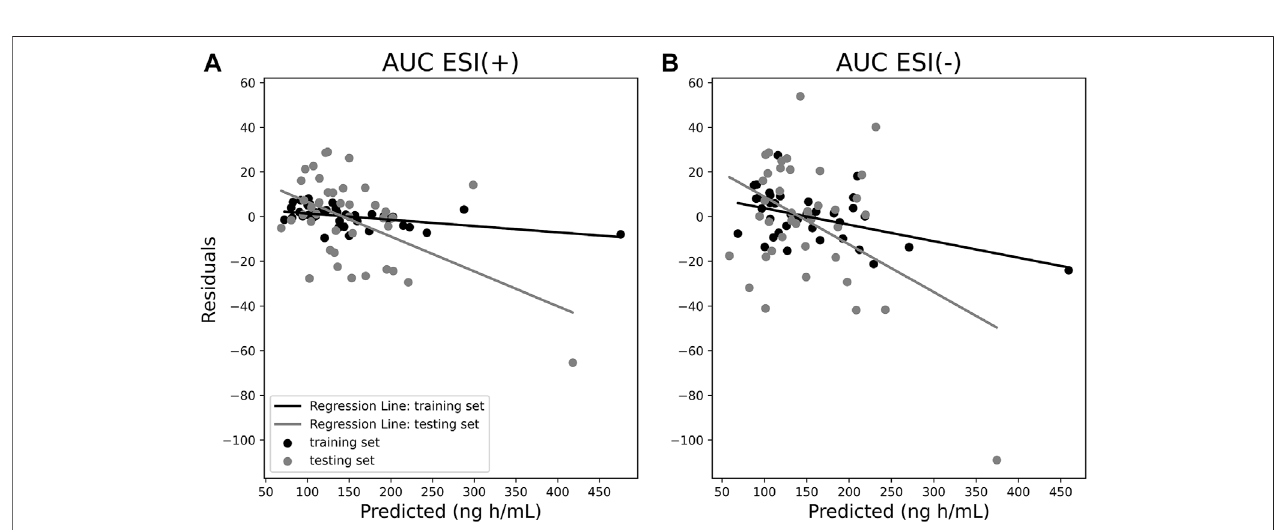
FIGURE 4 | Residual plots of ESI (+) (A) and ESI ( − ) (B) area under curve (AUC) models for both training (black dots) and leave-one-out cross-validation (LOOCv) testing samples (gray dots) as a dispersion diagram.